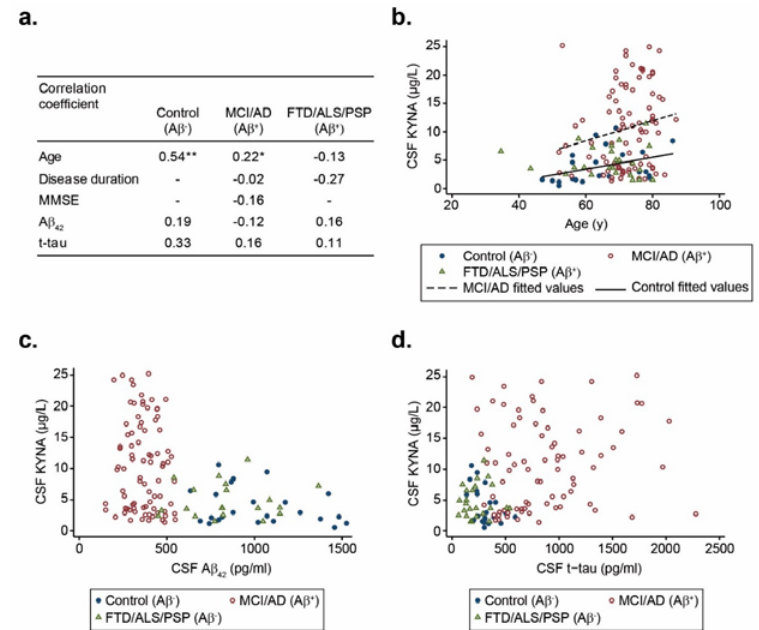
Figure 3. Spearman rank correlation facing KYNA levels in CSF with age, MMSE, disease duration, and A β 42 and t-tau levels within the AD-biomarker-diagnostic groups. Spearman rank correlation between KYNA levels in CSF, and age ( a , b ), A β 42 levels ( a , c ), and t-tau levels ( a , d ). Abbreviations: MCI, mild cognitive impairment; AD, Alzheimer’s disease dementia; FTD, frontotemporal dementia; ALS, amyotrophic lateral sclerosis; PSP, progressive supranuclear palsy; MMSE, Mini-Mental State Examination; A β 42 , amyloid- β 42; t-tau, total tau; KYNA, kynurenic acid; A β + , positive AD biomarker profile; Aβ - , negative AD biomarker profile. * p < 0.05; ** p < 0.01.